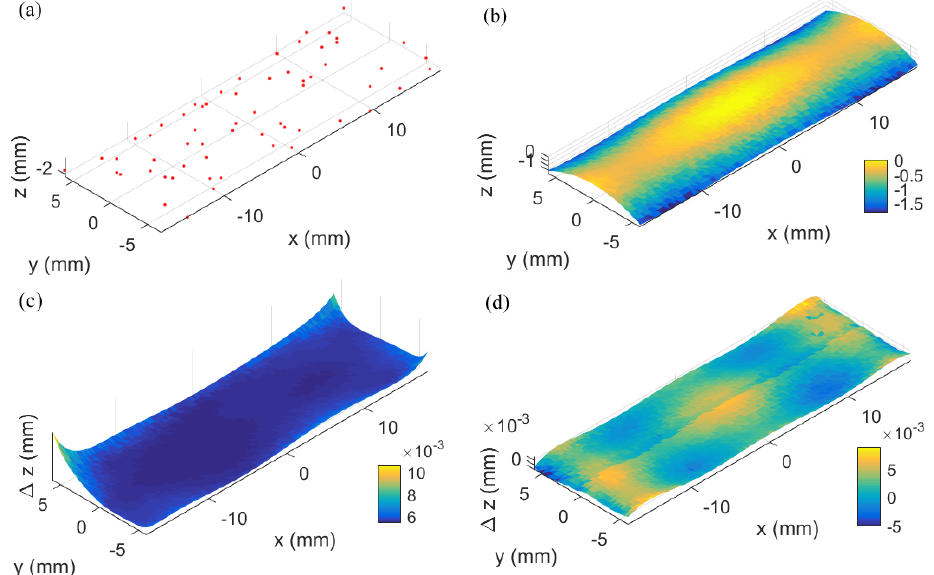
Figure 25. Measurement data and Gaussian process result: ( a ) raw data of measurement with the touch trigger probe; ( b ) mean surface; ( c ) associated uncertainty for the laser sensor; and ( d ) deviation of the mean surface from the reference data.